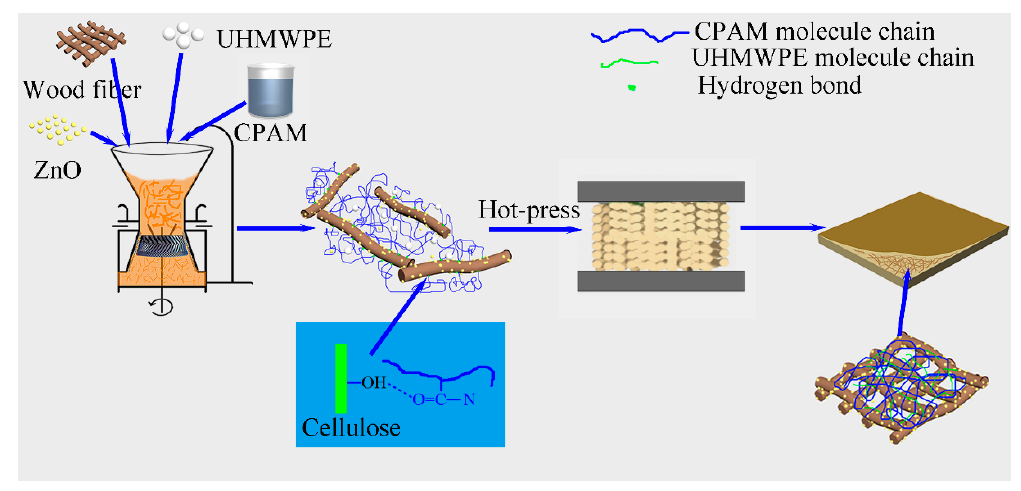
Figure 10. The synthesis of the PE/ZnO/wood-fiber composites.